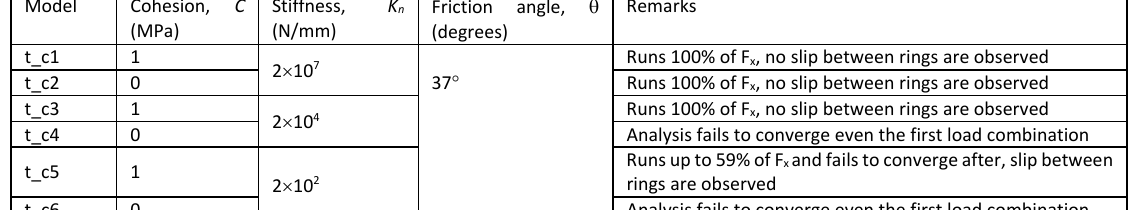
Table 6. Analysis for assessing the influence on the tower’s behaviour of the cohesion and normal stiffness of the concrete ‐ concrete contact. Model